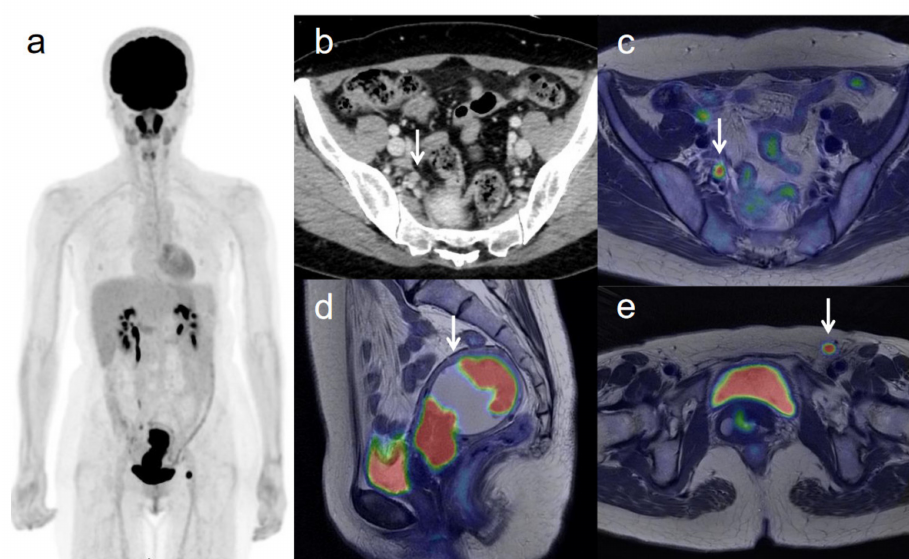
Figure 3. A 53-year-old woman with IVB cervical cancer and pelvic lymph node metastasis. ( a ) 18 F-FDG PET image shows FDG uptake by tumor in the cervical cervix (arrow) and right pelvic and left inguinal lymph nodes. ( b ) CT shows a right pelvic lymph node of short-axis diameter >1 cm (arrow). ( c ) Axial T2-weighted PET/MR image shows FDG uptake by the right pelvic lymph node (arrow). This finding is strongly suggestive of pelvic lymph node metastasis, which was confirmed by histopathologic examination. ( d ) Sagittal T2-weighted PET/MR image shows FDG uptake by the cervical tumor and invasion into the corpus uteri (arrow), which was confirmed by histopathologic examination. ( e ) Axial T2-weighted PET/MR image shows FDG uptake by the left inguinal lymph node